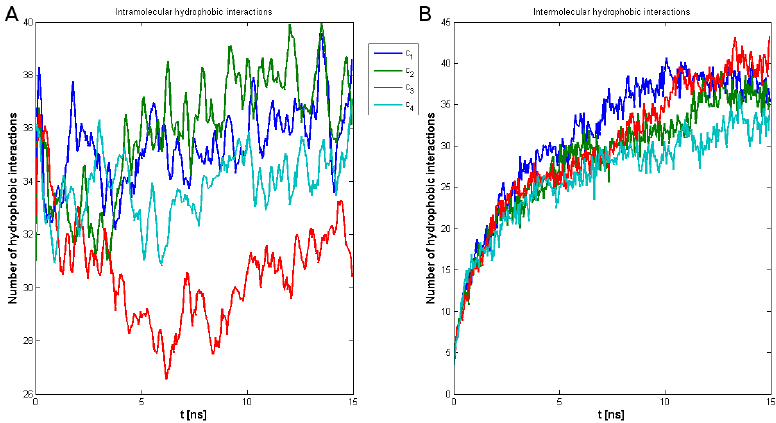
Figure 6. Total number of hydrophobic interactions for pathologic networks: ( A ) intra-molecular hydrophobic contacts are depicted; and ( B ) inter-molecular